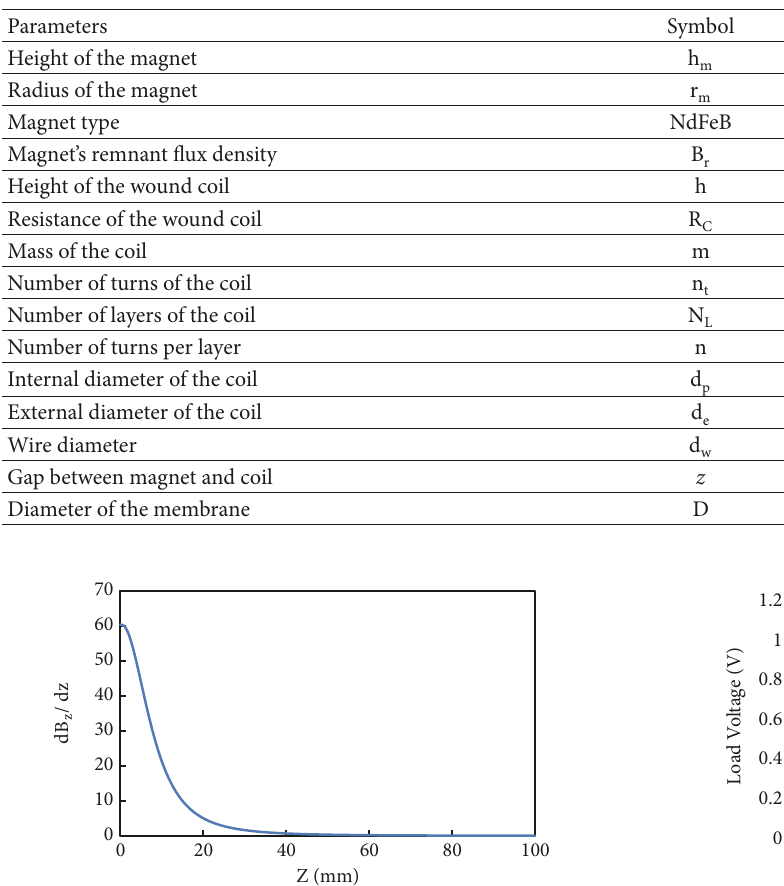
Table 2: Parameters and dimensions of the simulated energy harvester.